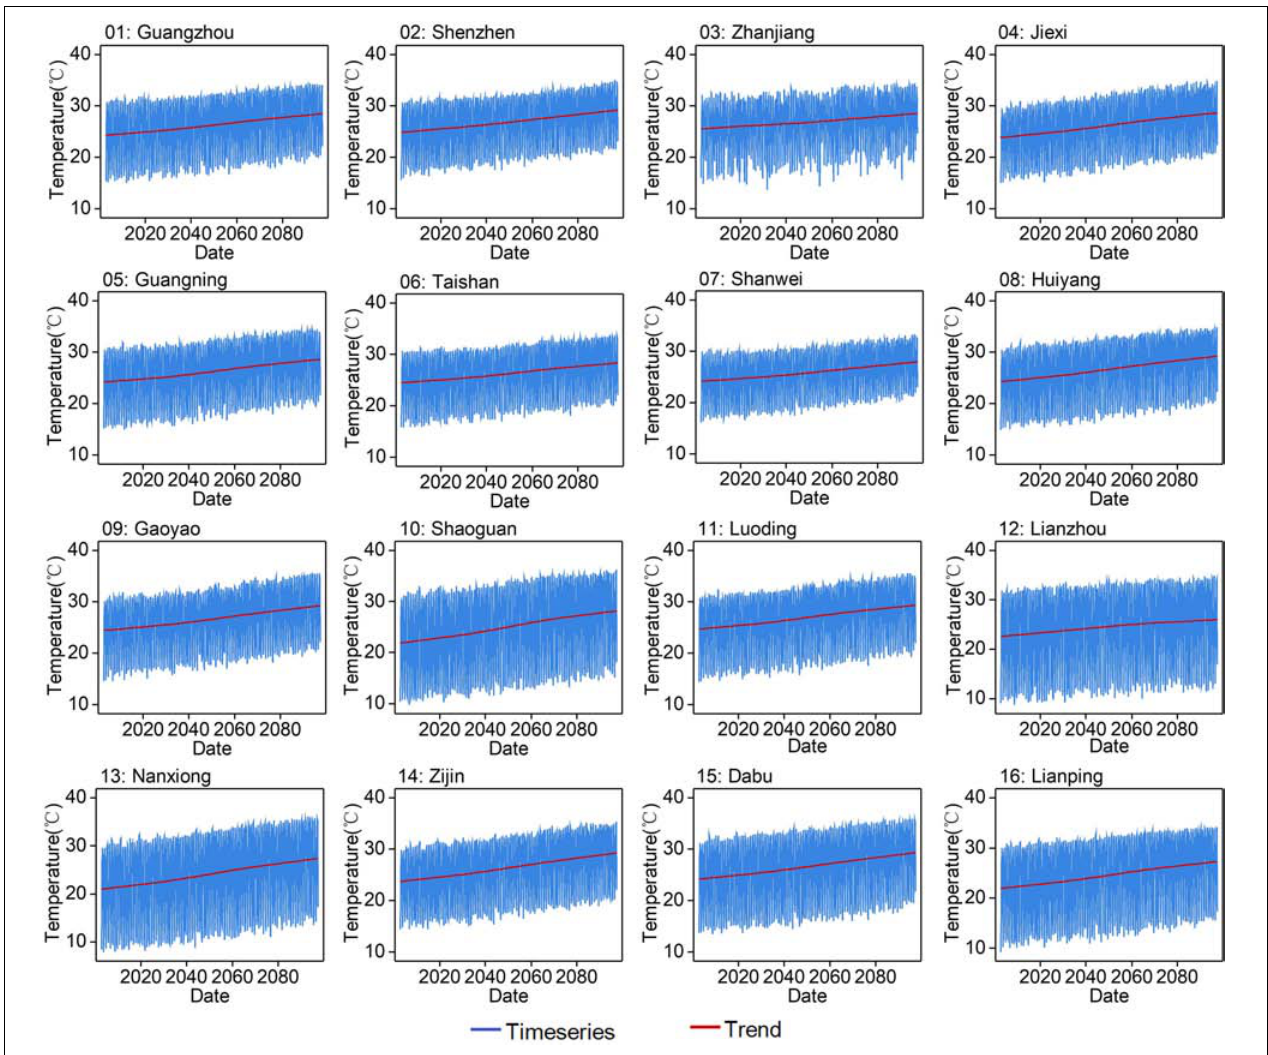
FIGURE 7 | Monthly projected Tmax of the ensemble of GCMs (i.e., CNRM-CM5, CSIRO-Mk3.6.0, IPSL-CM5A-MR, and MIROC5) from 2006 to 2100 under RCP8.5.